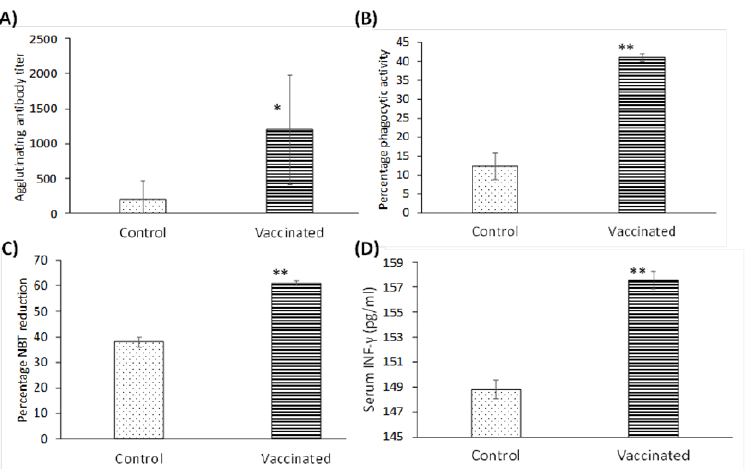
Figure 4. PAGs increase immunological responses in diabetic rats after oral vaccination. ( A ) Agglu- tinating antibody titers as determined by the slide agglutination test. Percentage phagocytic ( B ) and NBT reduction ( C ) activity was also evaluated. ( D ) Serum IFN- γ was determined by ELISA. All tests were carried out on samples recovered on day 34 of the vaccination regimen. All experiments were repeated twice. (*) p < 0.05; (**) p < 0.001 using Mann – Whitney test ( A ) and Student’s t test ( B – D ) (N = 6).